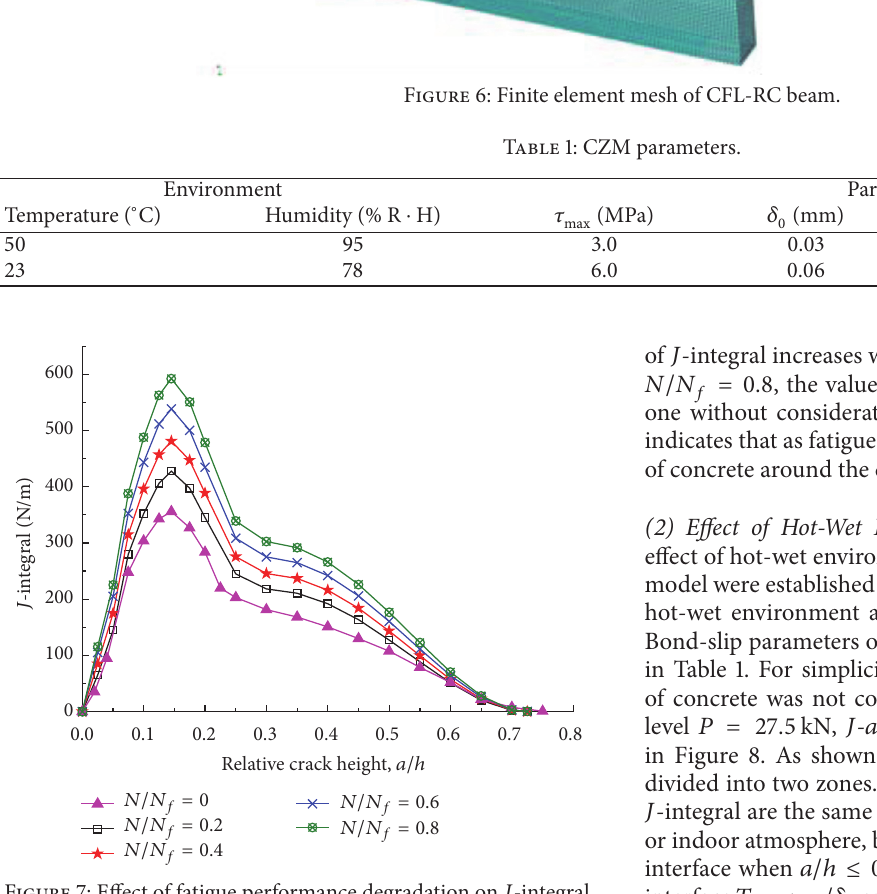
Figure 7: Effect of fatigue performance degradation on 𝐽 - integral.